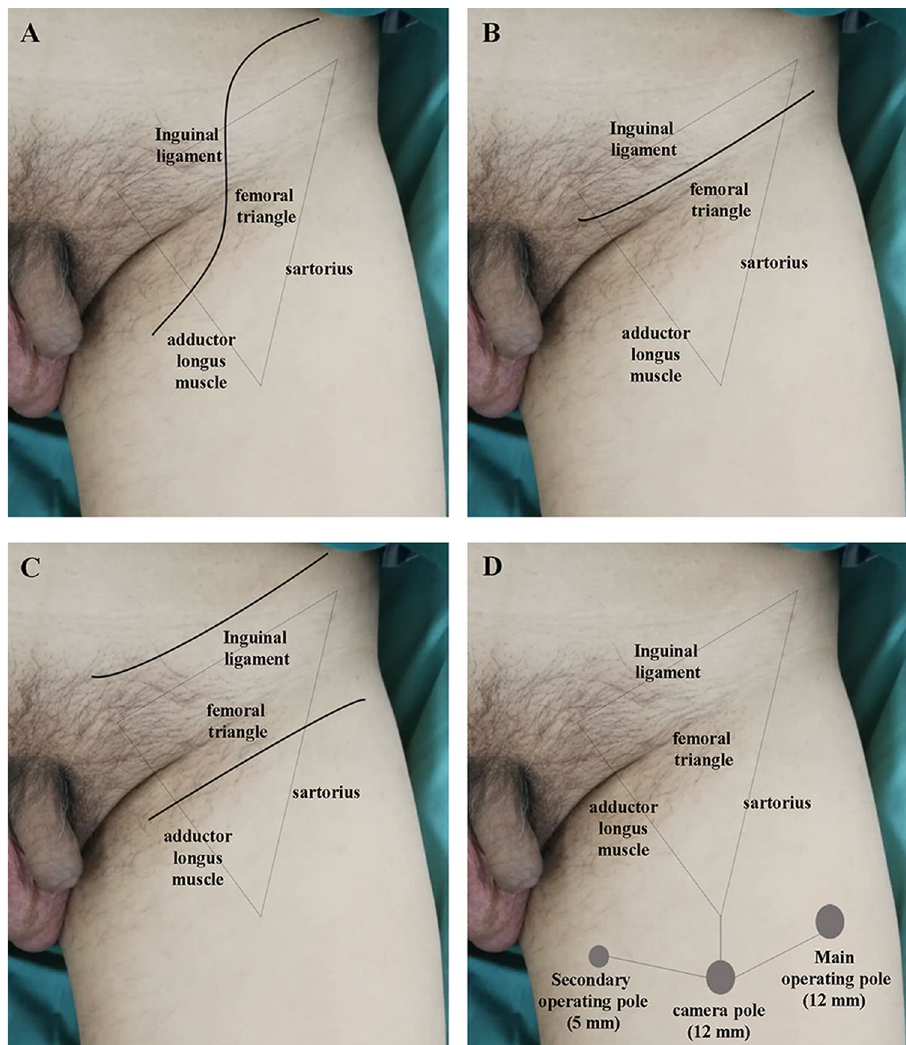
Figure 1. Incisions for different surgical techniques (left side view). ( A ) S-shaped incision; ( B ) Single oblique incision; ( C ) skin bridge incision (Fraley incision); ( D ) Trocar placement of laparoscopic inguinal